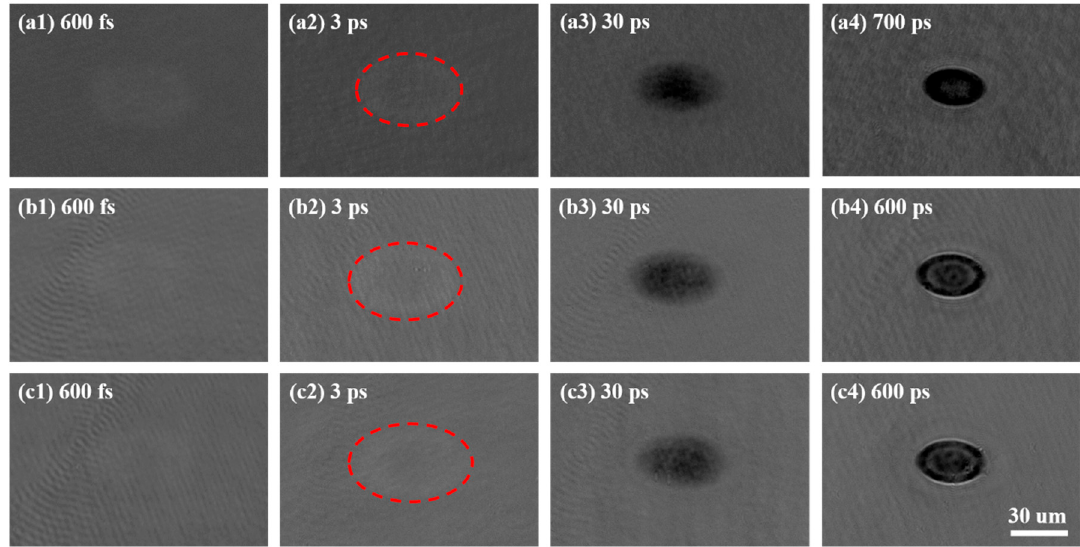
Figure 4. The transient non-equilibrium states of different phase states GST films excited by a single femtosecond laser pulse with the fluence of 0.045 J/cm 2 . ( a1 – a4 ) Images of transient non-equilibrium states of amorphous state films, ( b1 – b4 ) images of transient non-equilibrium states of crystalline FFC structure films, ( c1 – c4 ) images of transient non-equilibrium states of crystalline HCP structure films.